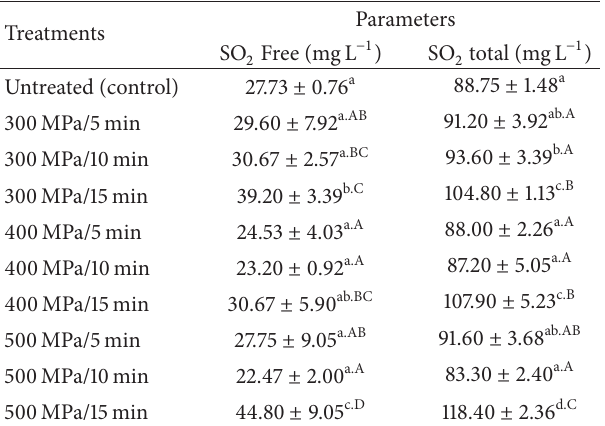
Table 3: Effects of HHP on free and total SO 2